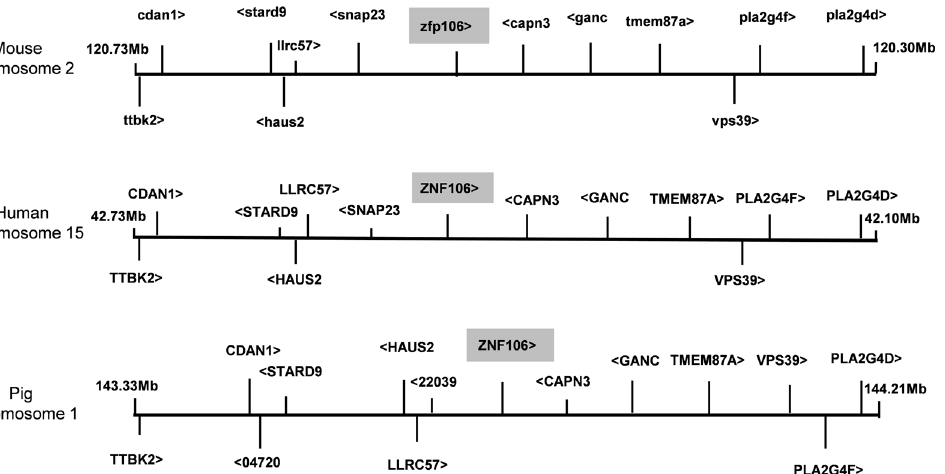
Fig 3. Conservation of synteny of genomes in the region of the ZNF106 ( Zfp106 ) gene (Ensembl 83; www.ensembl.org). Only protein coding genes are shown. The protein 04720 in the pig genome is uncharacterised, while 22039 bears homology to human SNAP23 but is truncated. Arrowheads indicate direction of